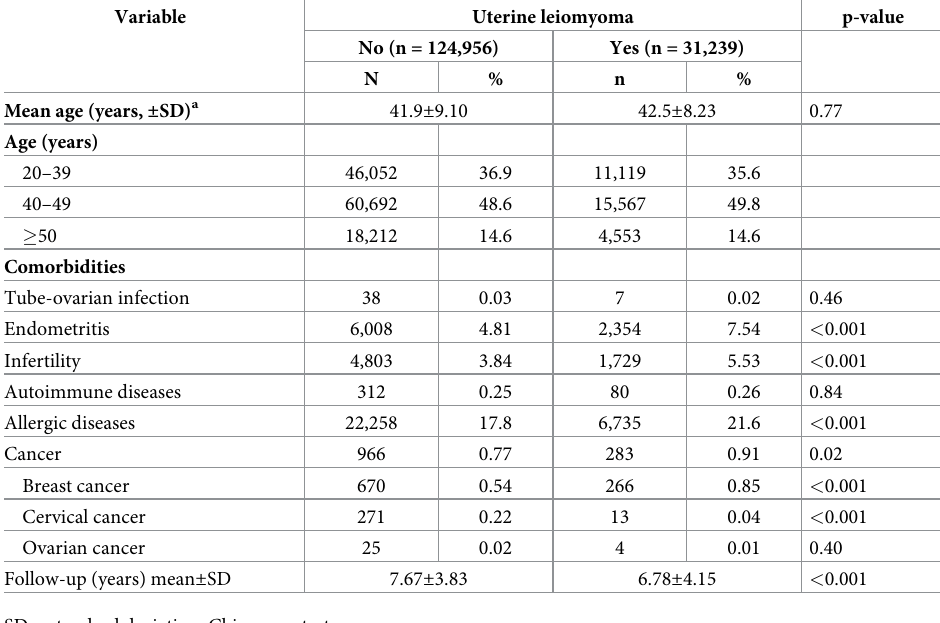
Table 1. Baseline variables for patients with uterine leiomyoma and